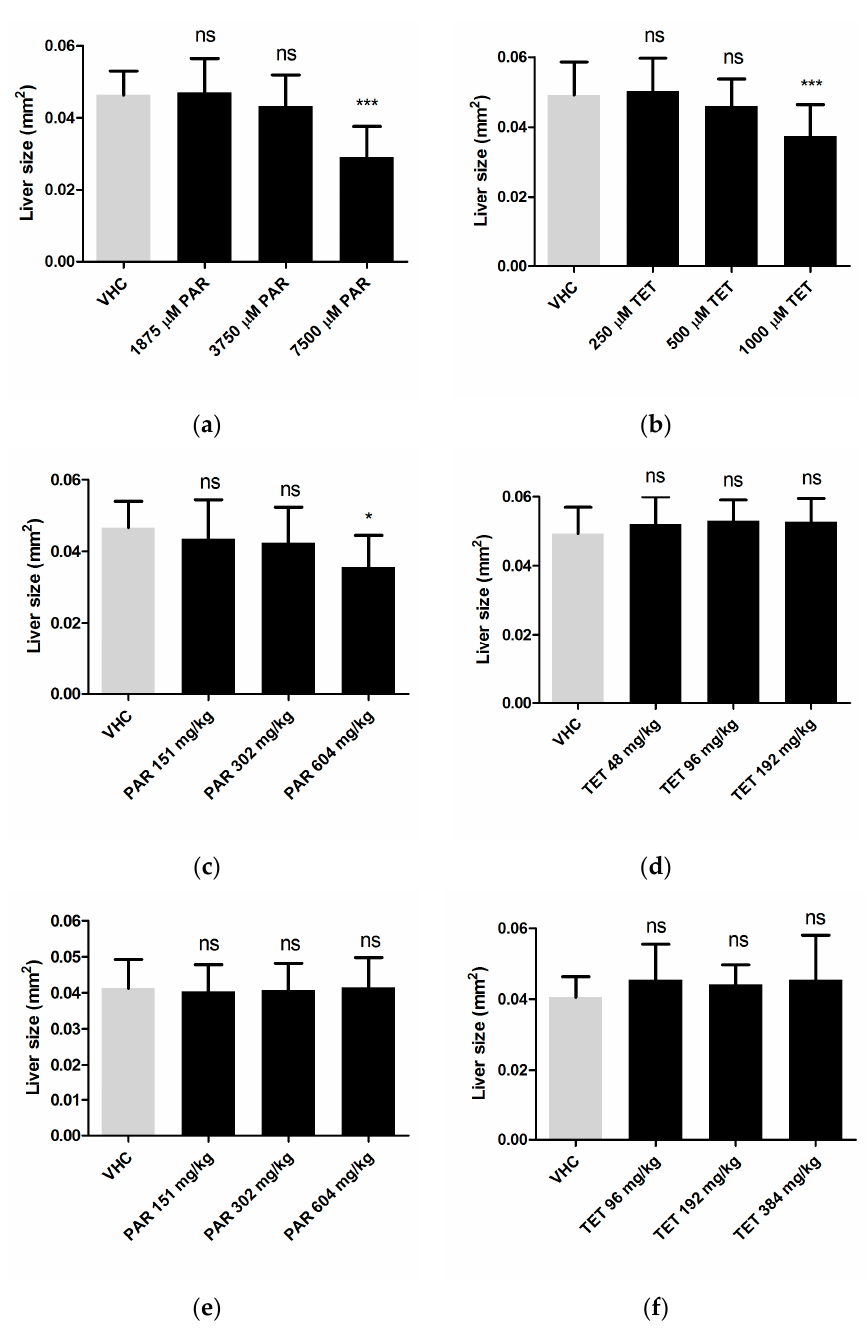
Figure 4. Hepatotoxicity assessed by size analysis of fluorescent 2D liver images after immersion ( a , b ); yolk injection ( c , d ) and pericardial injection ( e , f ) of paracetamol ( a , c , e ) and tetracycline ( b , d , f ). Analysis was performed after three days of treatment (immersion) or three days after treatment (injection), at 6 dpf. A total of 10 and 12 larvae were used individually per condition for immersion and injections, respectively. The experiment was performed in triplicate and data were pooled. The data were analyzed using one-way ANOVA. ns: no statistically significant difference; *: p < 0.05, ***: p < 0.001; VHC: vehicle control; PAR: paracetamol; TET: tetracycline. Means ± SD are shown.